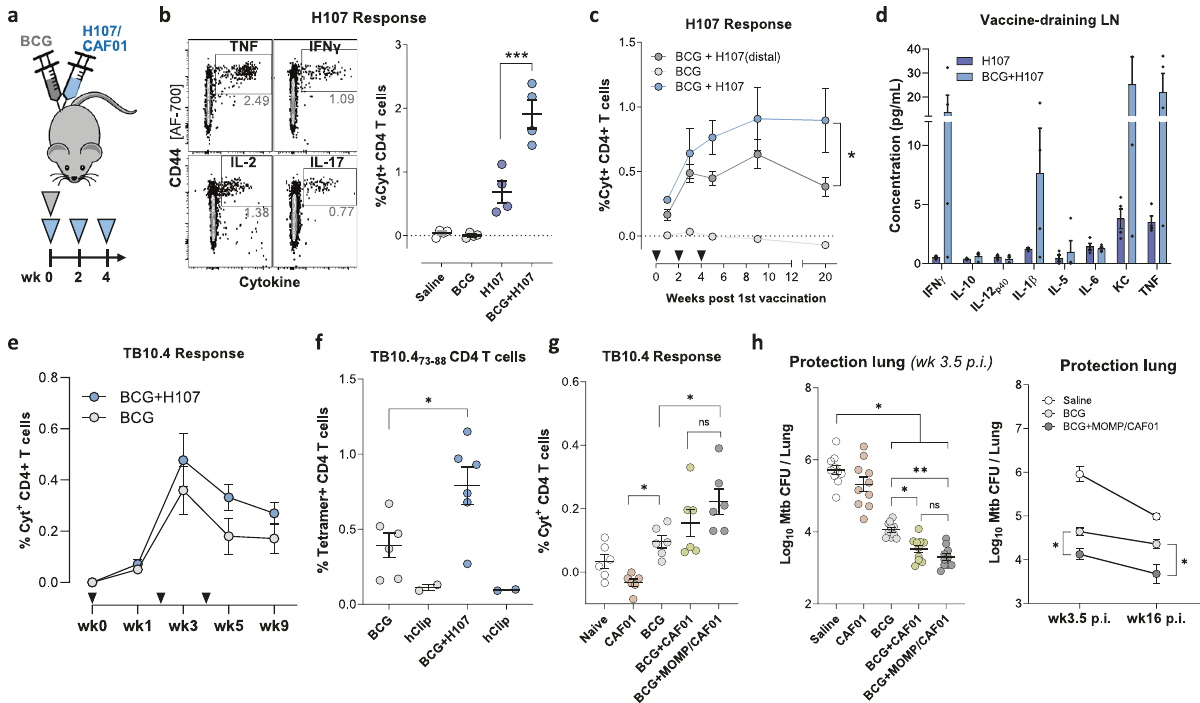
Fig. 3 Co-administration of BCG + H107 adjuvants both H107- and BCG-speci fi c immune responses. a Schematic representation of the BCG + H107 co- administration regimen. Mice were vaccinated once with BCG and H107/CAF ® 01 s.c. at the base of the tail and boosted twice with H107/CAF ® 01 s.c., at 2-weekly intervals. b Sample contour plots of gating (left) of ICS analysis to determine the percentage of total cytokine-producing (IFN- γ [PE/Cy7], IL-2 [APC/Cy7], TNF [PE] and/or IL-17A [PerCP/Cy5.5] via Boolean OR gating) CD44 high CD4 T cells after ex vivo restimulation of splenocytes with H107 protein one week post fi nal H107 vaccination and cumulative data for each vaccine group (right). H107 vs. BCG + H107 p = 0.0003. c H107-speci fi c responses in the spleen over a time course after BCG + H107 co-administration at sites either draining to the same (blue) or distal (dark gray) lymph nodes ( n = 4). Triangles indicate vaccination events, One-Way ANOVA with Dunnett ’ s Multiple Comparison test, BCG + H107 vs. BCG + H107(distal), p = 0.0358. d Cytokine levels in supernatants taken after homogenization of vaccine-draining lymph nodes one week post fi nal H107 vaccination from H107(dark blue) and BCG + H107 (light blue) immunized mice ( n = 4). e Percentage of cytokine-producing (IFN- γ , IL-2, TNF, and/or IL-17A) CD44 high CD4 T cells after restimulating splenocytes with recombinant TB10.4 protein in BCG (gray) and BCG + H107 (blue) vaccinated mice ( n = 4, mean ± SEM). Triangles indicate vaccination events. f TB10.4-speci fi c CD4 T cells in the spleen as determined by I-A d :TB10.4 73-88 tetramer binding one week post fi nal H107 vaccination ( n = 6). I-A d :hCLIP 103-117 negative controls included in duplicates for each group (sample pooled from six animals). Two-tailed unpaired t (naïve), CAF ® 01 adjuvant alone, BCG, BCG + CAF ® 01 or BCG + MOMP/CAF ® 01. CAF ® 01 vs. BCG p = 0.0398, BCG vs. BCG + MOMP/CAF ® 01 p = 0.0465. h Bacterial burden in the lungs 3.5 and 16 weeks post aerosol Mtb infection (p.i.) ( n = 8). b , f , g , h Lines indicated mean ± SEM with symbols indicating individual mice. All data are plotted as mean ± SEM. b , c , g , h One-Way ANOVA with Tukey ’ s Multiple Comparison test. p values; * p <